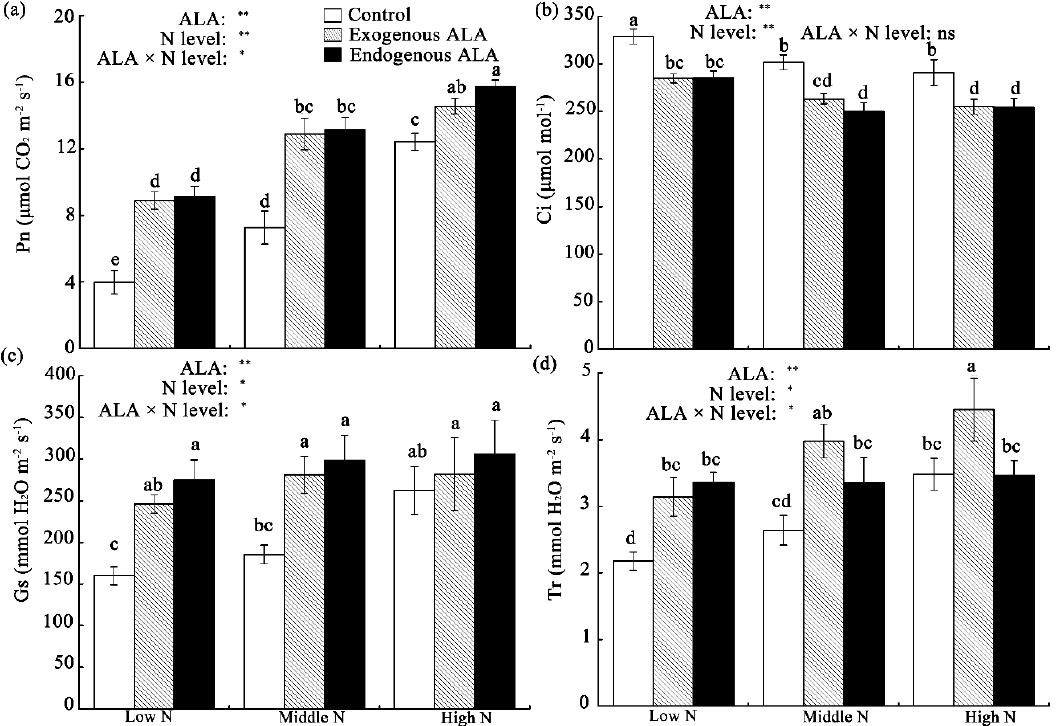
Figure 2. Differences in ( a ) net photosynthetic rate (Pn), ( b ) intercellular CO 2 concentration (Ci), ( c ) stomatal conductance (Gs), and ( d ) transpiration rate (Tr) in exogenously-treated and endogenous ALA-overproducing canola leaves grown under low-, middle-, and high-N conditions. Values are means ± standard errors ( n = 10). The same letter indicates no significant difference ( p > 0.05) according to Duncan’s test. Sources of variation: ALA, N-level, and ALA × N-level interaction; * p < 0.05; ** p < 0.01; ns: not significant.